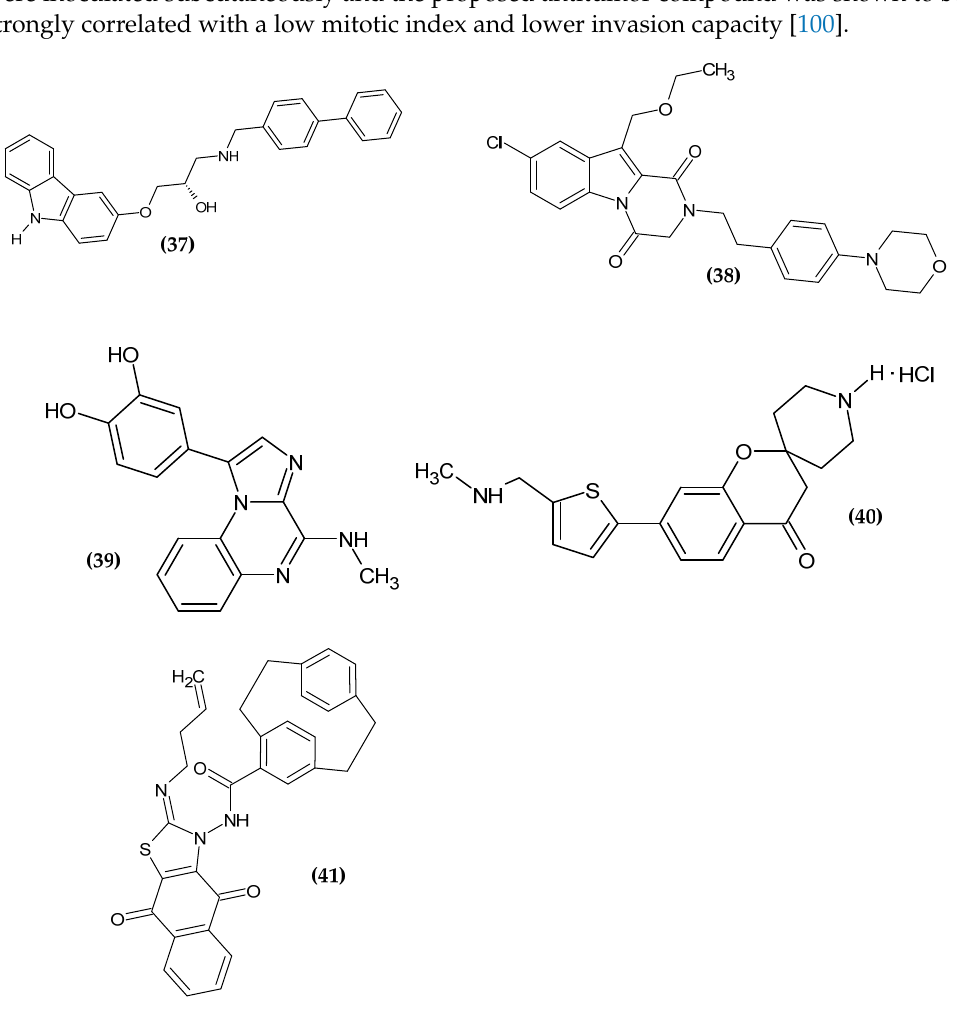
Figure 9. Heterotricyclic derivatives with anti-melanoma activity.